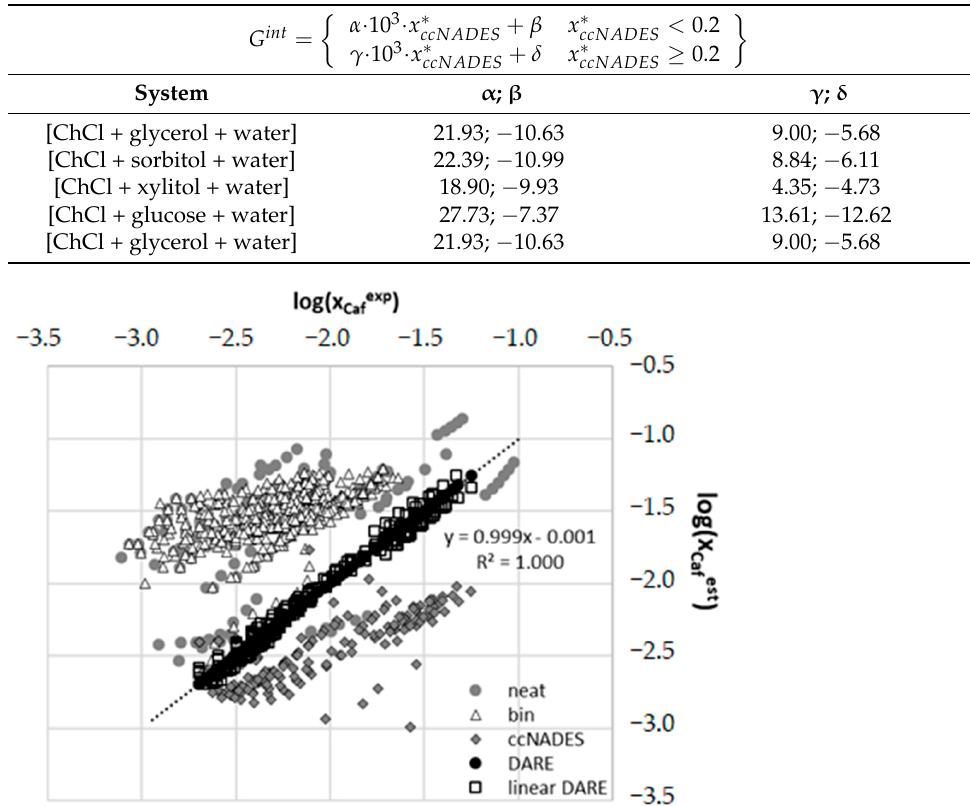
Figure 11. The comparison of accuracy of COSMO-RS computed solubilities of caffeine in neat and binary solutions with experimental data. Additionally, two COSMO-RS-DARE extensions were included, namely first one resulting from the full optimization and the second one corresponding to G int expressed as split linear functions with values documented in Table 2.